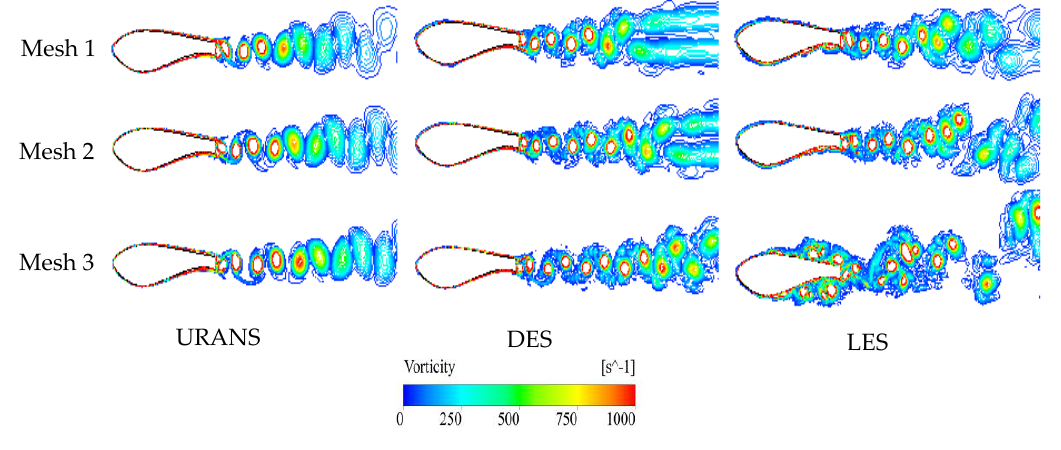
\ Figure 5. Vortices Figure 5. Vortices contours.